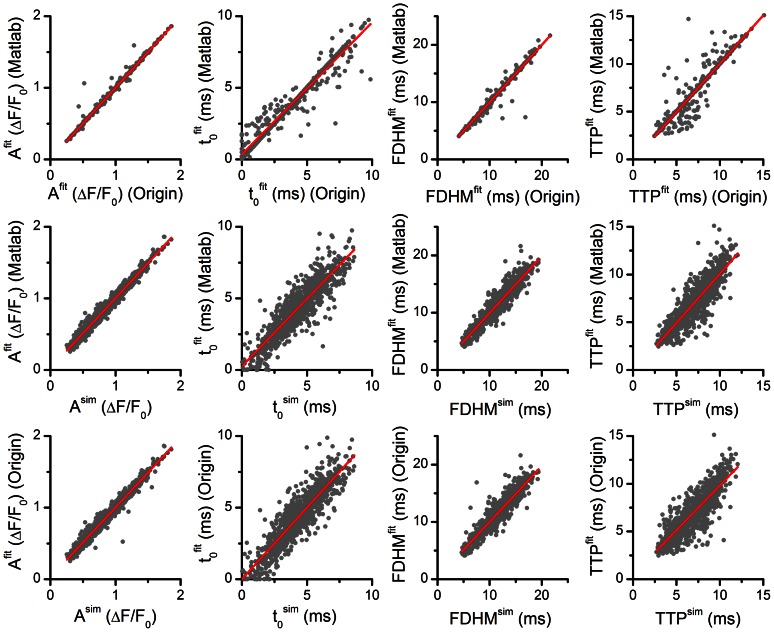
Comparison of the parameter values estimated by different fitting procedures.The Levenberg-Marquardt algorithm in Origin and the Trust-Region algorithm implemented in MATLAB were used on a dataset of 1000 simulated spikes with white noise and normally distributed parameter values. Top row – correlation between parameter values estimated by fitting simulated spikes in Origin and in MATLAB. Middle row – comparison of the fitted parameter values obtained in MATLAB with the input parameter values used in simulations. Bottom row – comparison of the fitted parameter values obtained in Origin with the input parameter values used in simulations. Red lines are linear fits (correlation coefficients are given in Tables S4 in File S1. It should be noted that a majority of the data points lie exactly under the regression lines.